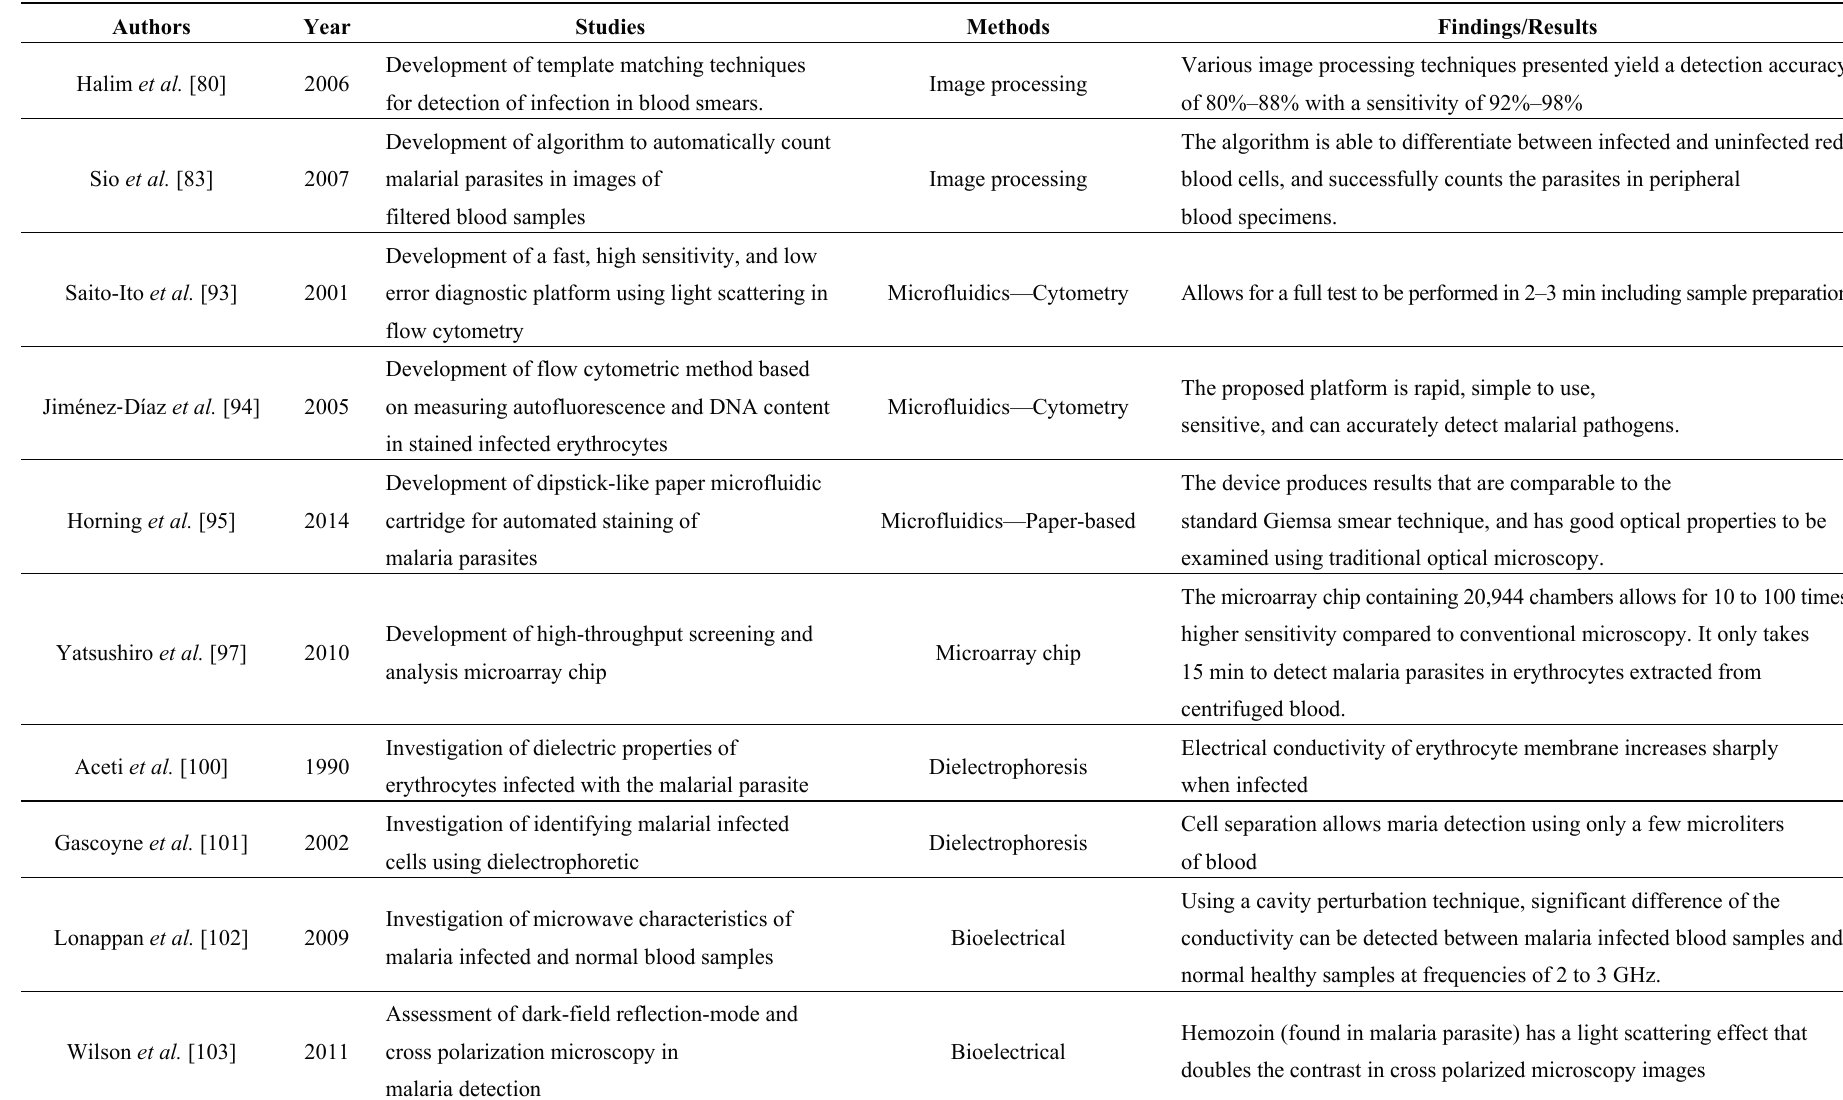
Table 5. Summary of biomedical engineering techniques in malaria